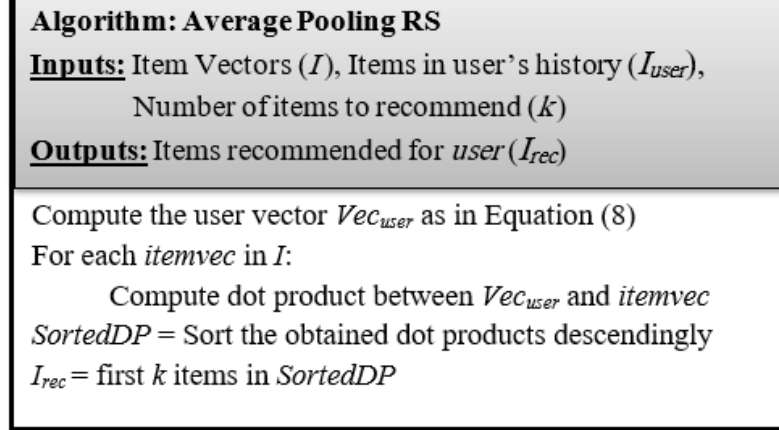
Figure 1. Recommender Systems Average Pooling Method.